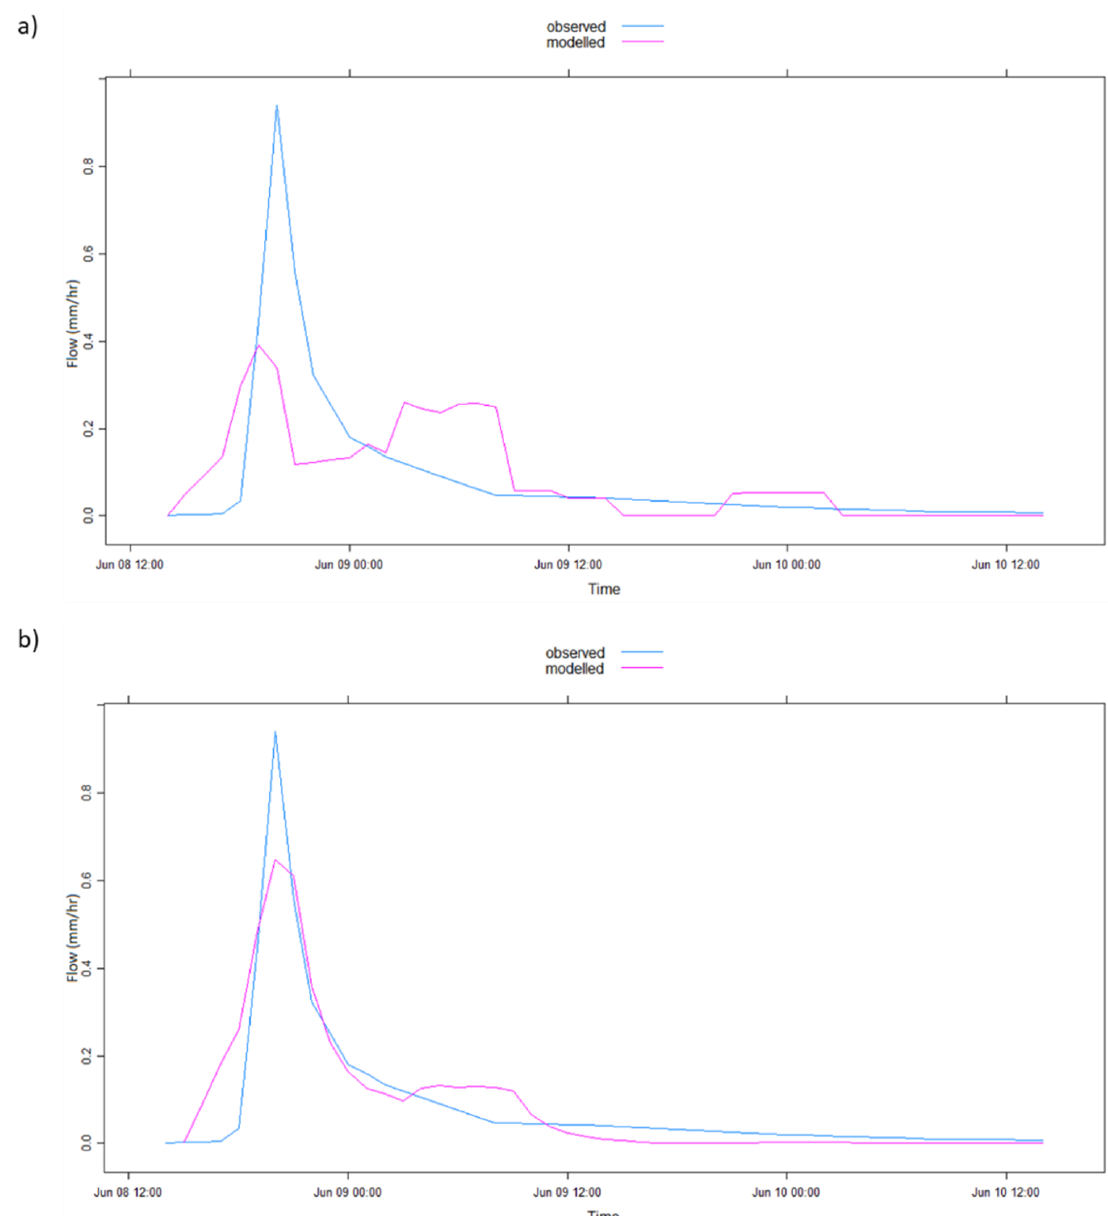
Figure 5. IHACRES model simulation results with ( a ) rsq_daily and ( b ) rsq_hourly objective functions for the 2002a flood event.